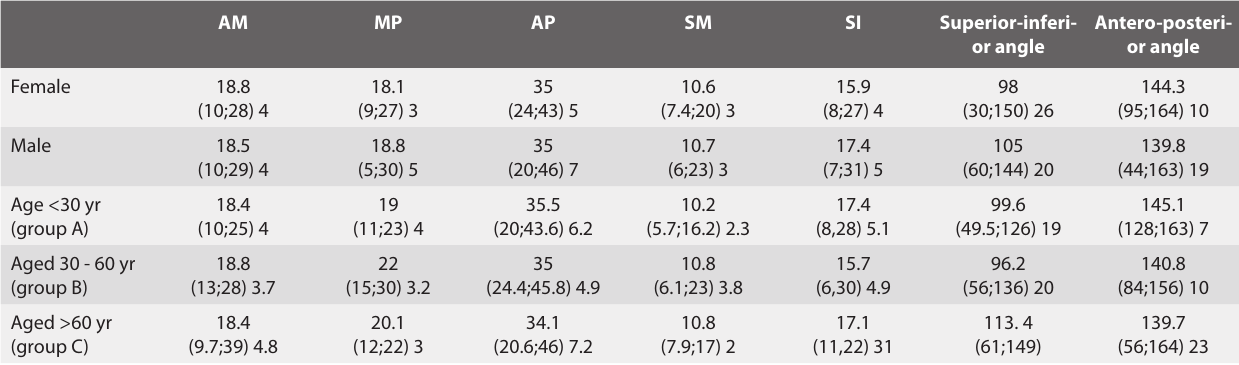
Table 2. Mean values (min - max: SD) of the anthropometric variables based on gender and age.